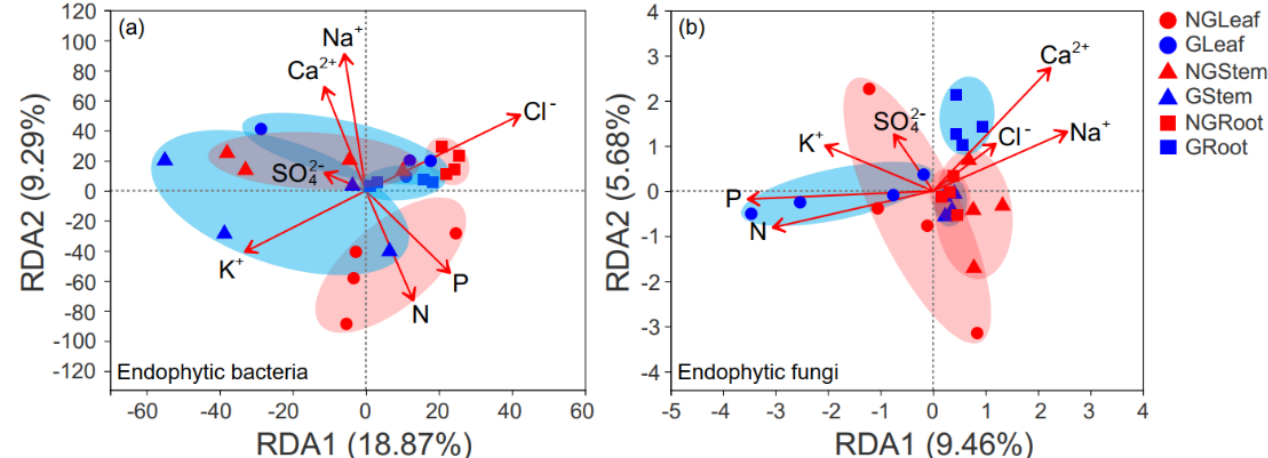
Figure 5. Redundancy analysis (RDA) analysis illustrating the relationship between endophytic microbial communities among different tissues of Leymus chinensis and environmental variables: ( a ) endophytic bacterial community, ( b ) endophytic fungal